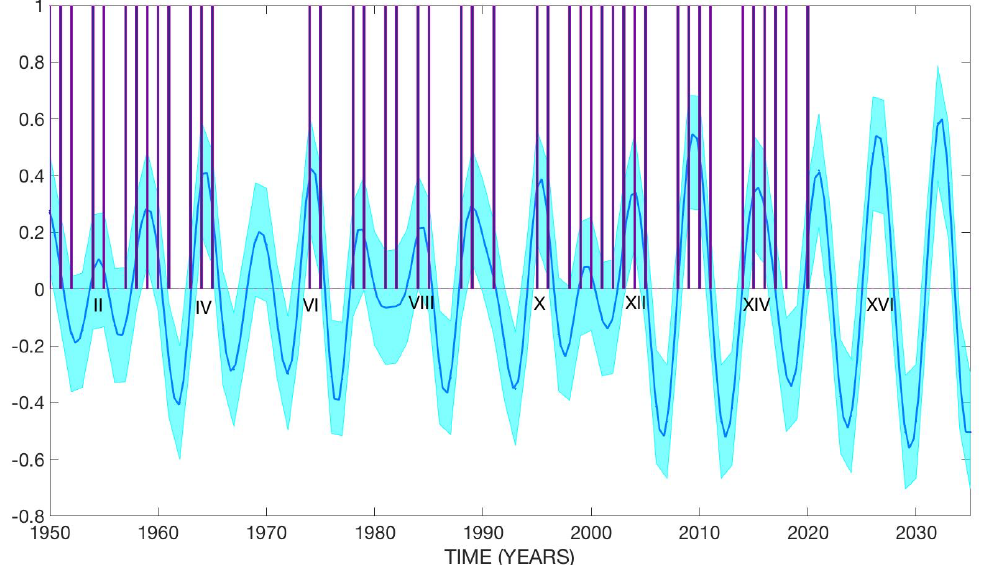
Figure 4. Probabilistic hindcasts and forecasts for the category 4 Atlantic hurricanes. Bayesian inference of the LS-SVM model (blue line and shade) compared with the historical category 4 Atlantic hurricanes (purple vertical bars) clustered in 15 groups (I–XV). In addition, the probabilistic prediction for category 4 Atlantic hurricane is shown for the following period (cluster XVI). The blue shaded area represents the 95% confidence intervals of the Bayesian